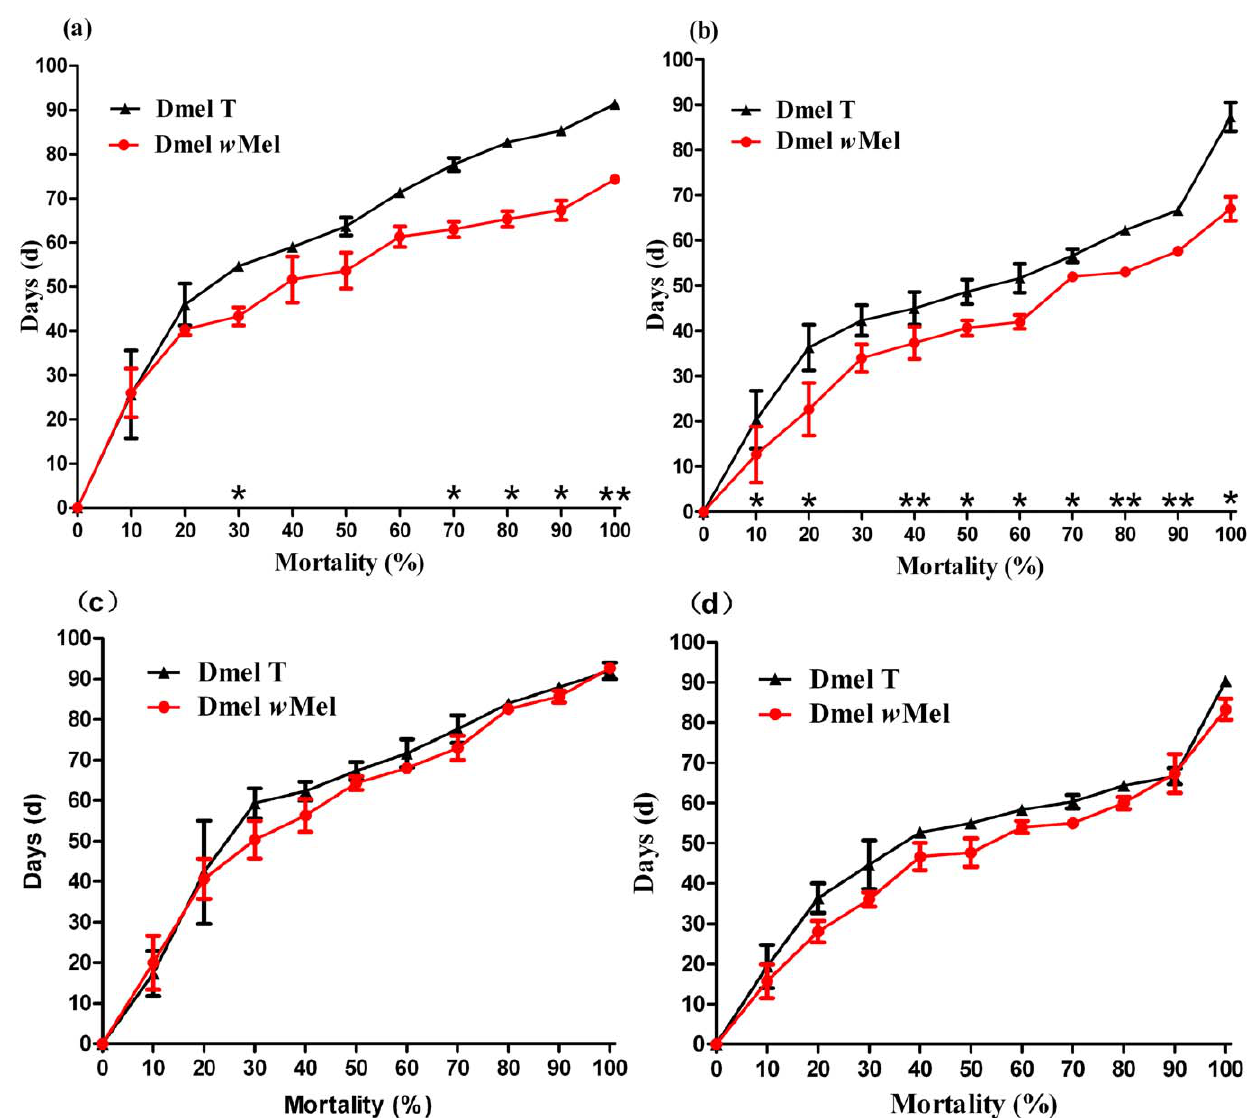
Figure 3. The longevities of Wolbachia -infected and -uninfected flies living in the medium infused either 300 m g ? ml 2 1 (a, b) or 0 m g ? ml 2 1 (c, d) of lead. ( a, c ) Female adults. ( b, d ) Male adults. Bars=standard error; ‘‘*’’ indicated P , 0.05; ‘‘**’’ indicated P , 0.01.